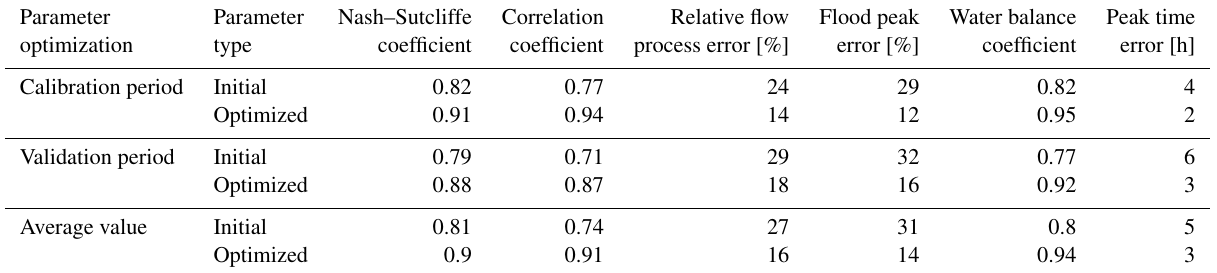
Table 3. Flood simulation evaluation indices without and with parametric optimization. Parameter Parameter Nash–Sutcliffe Correlation Relative flow Flood peak Water balance Peak time optimization type coefficient coefficient Calibration period Initial Validation